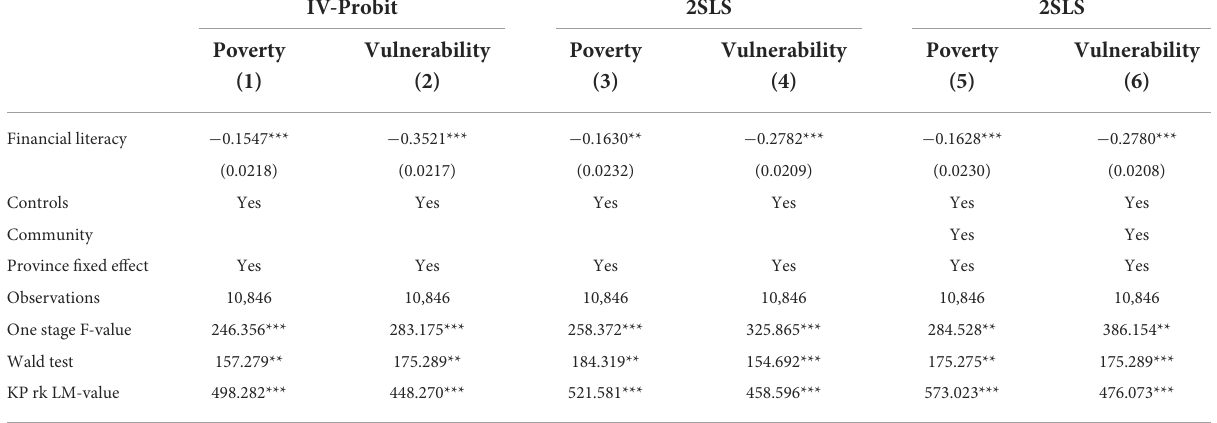
TABLE 6 Estimation results of using the instrumental variable.